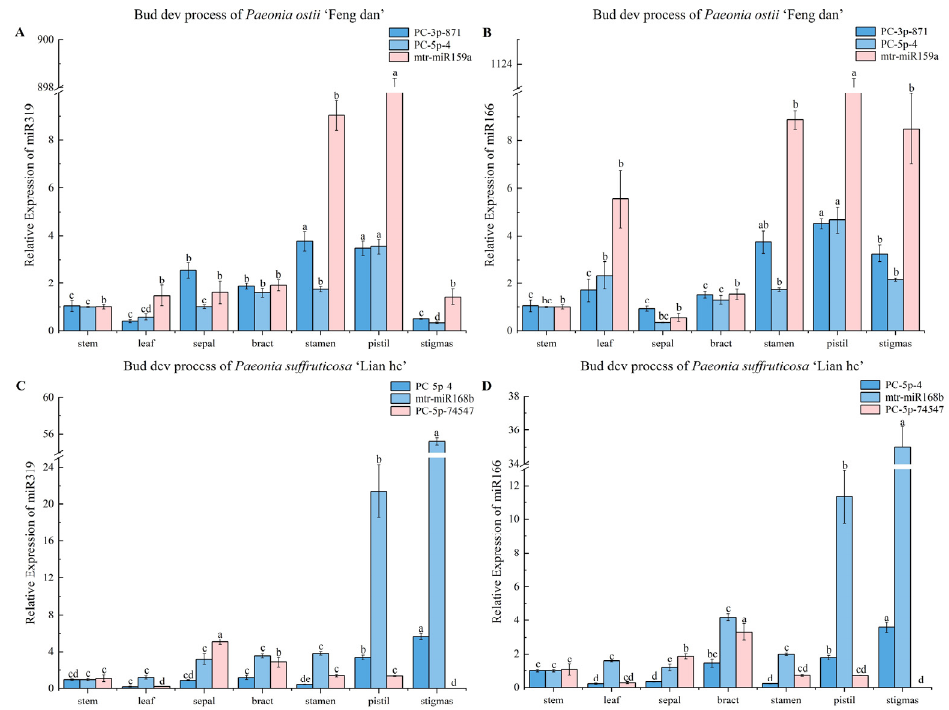
Figure 11. Performance evaluation of miR319 ( A , C ) and miR166 ( B , D ) expression standardization during different tissues using reference miRNAs. The legend represents the internal reference used in calculating the relative expression amount. Different lowercase letters represent significant differences ( p < 0.05). Error bars are standard error of mean (SEM).